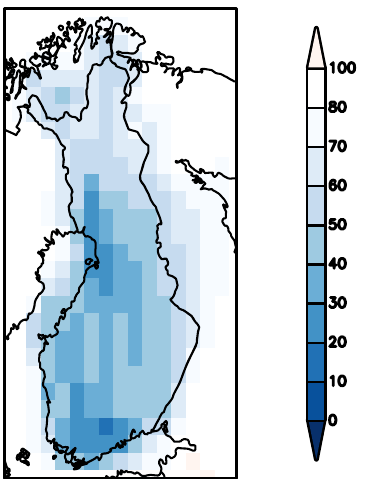
Fig. 15. The percentage of the cross-border BC to the total black carbon load obtained by switching off the emissions in Finland for the year 2005.